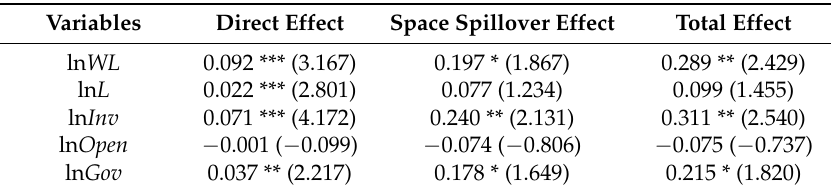
Table 8. The direct effect of the development of logistics industry on regional economic growth, spatial spillover effect and total